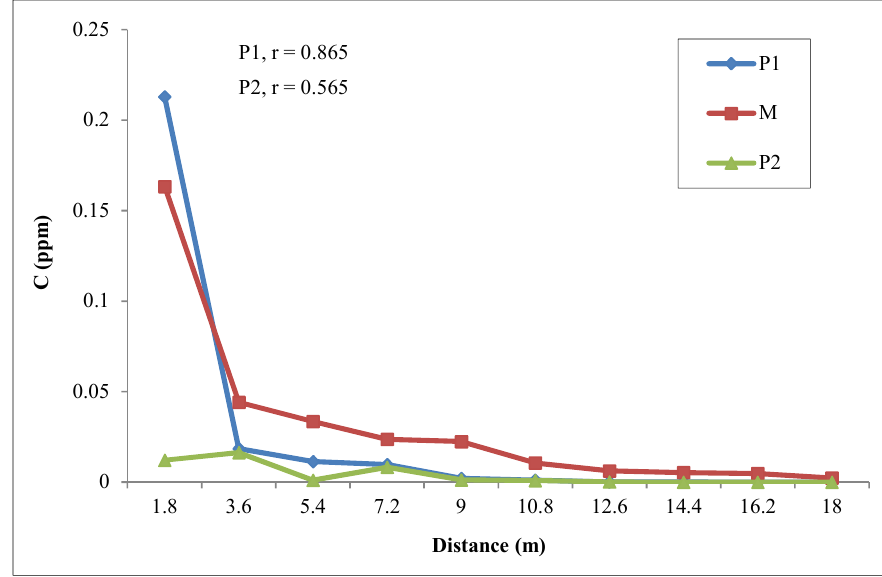
Figure 13. Measured and Predicted Concentrations against Distance for the month of May.